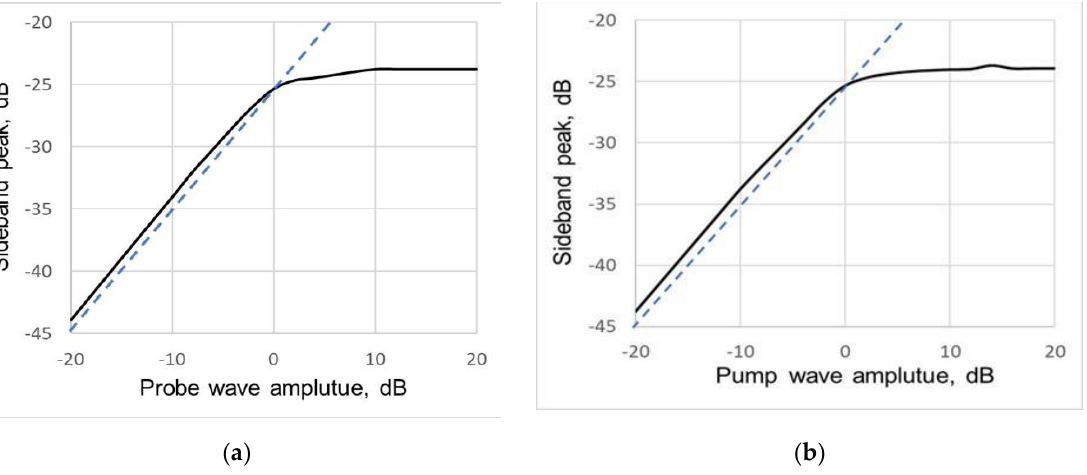
Figure 14. Dependence of the first sideband peak (A+) on ( a ) the probe wave amplitude and ( b ) the pump wave amplitude calculated from the bilinear model. The dotted lines show the same dependences from the quadratic model.